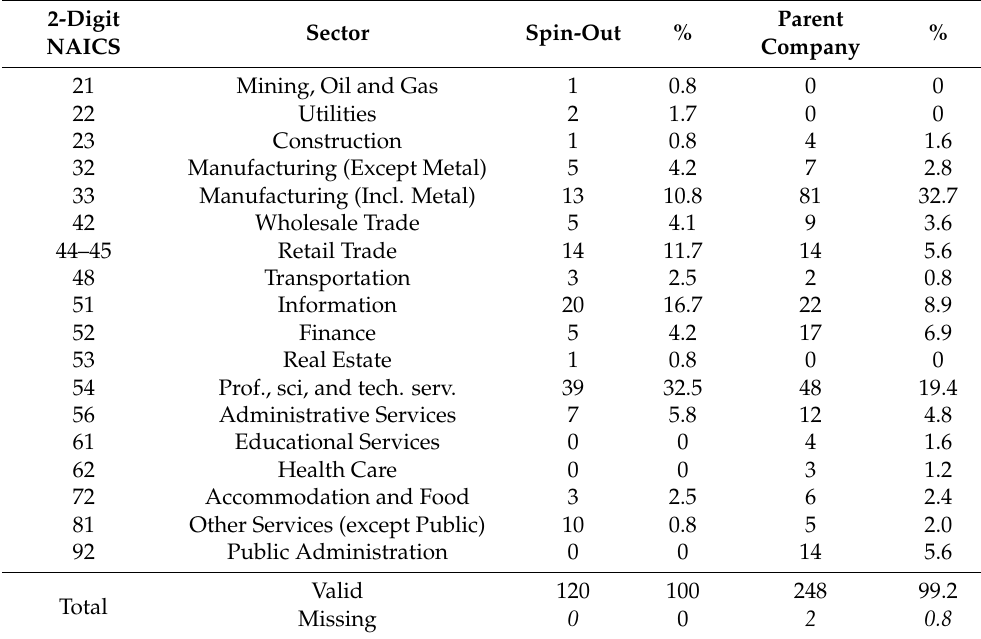
Table 2. Spin-outs and the sectors of the parent